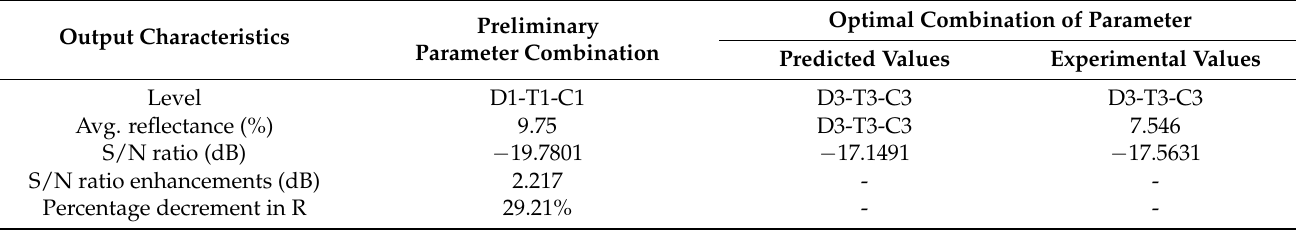
Table 4. Confirmation test for Taguchi predicted optimum parameter